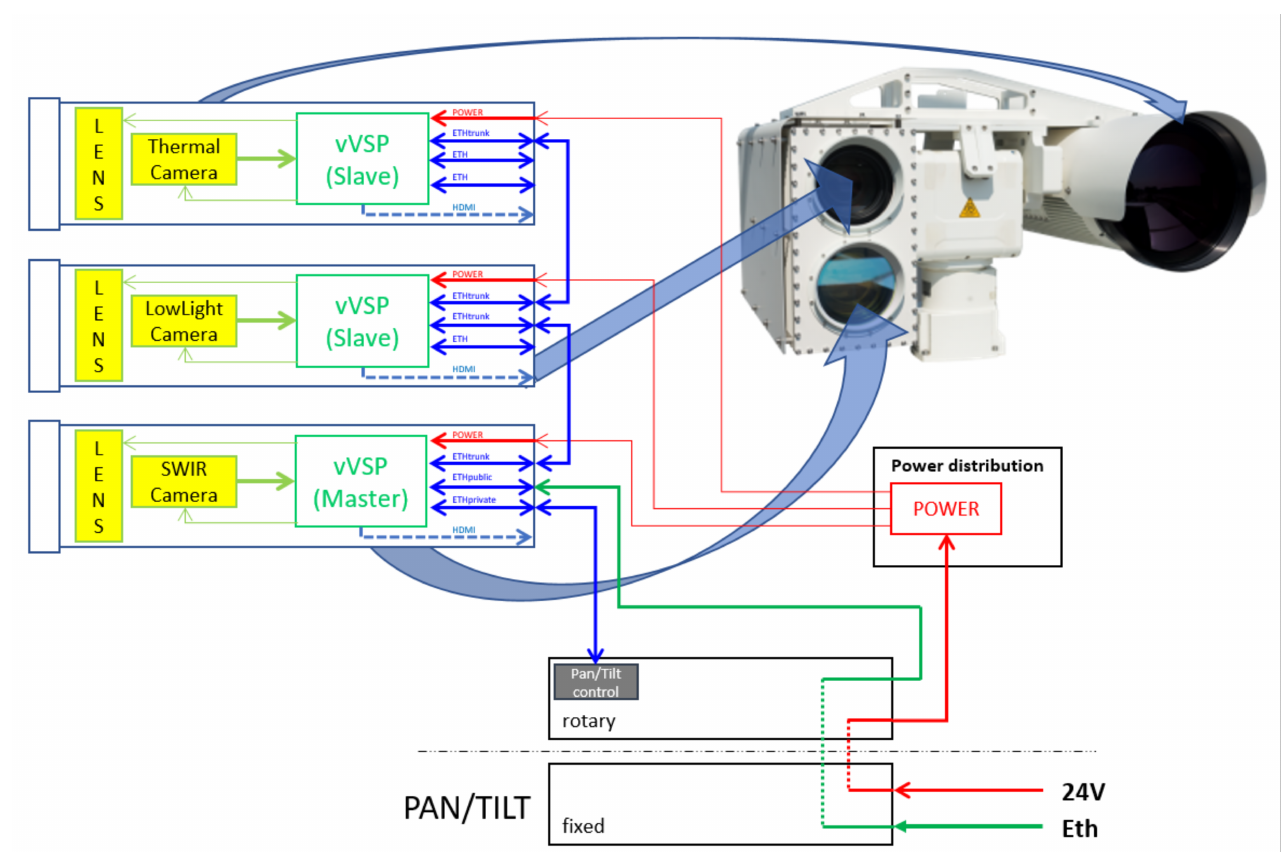
Figure 2. Distributed VMSIS3